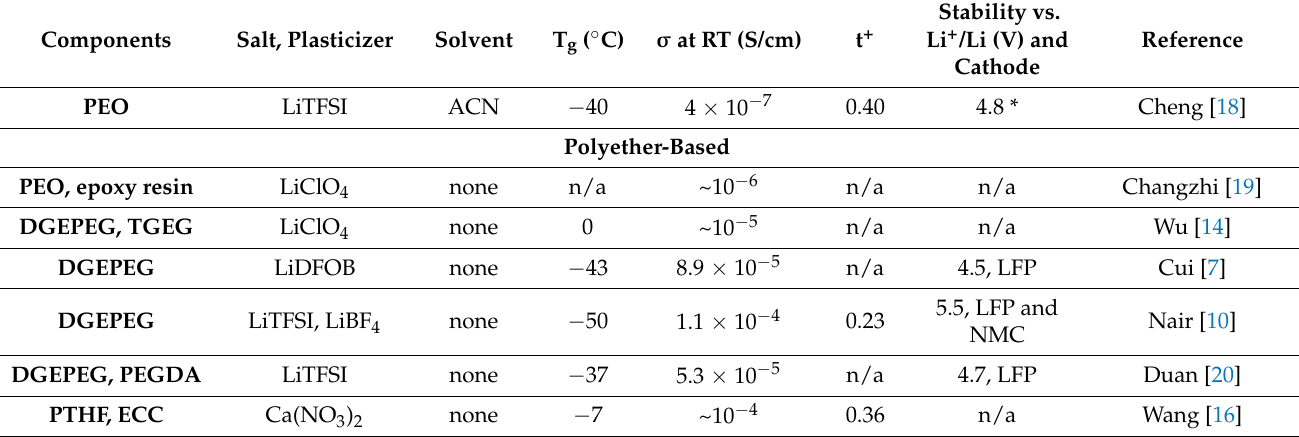
Table 1. Thermal and Electrochemical properties of Epoxide-Based Solid Polymer Electrolytes.